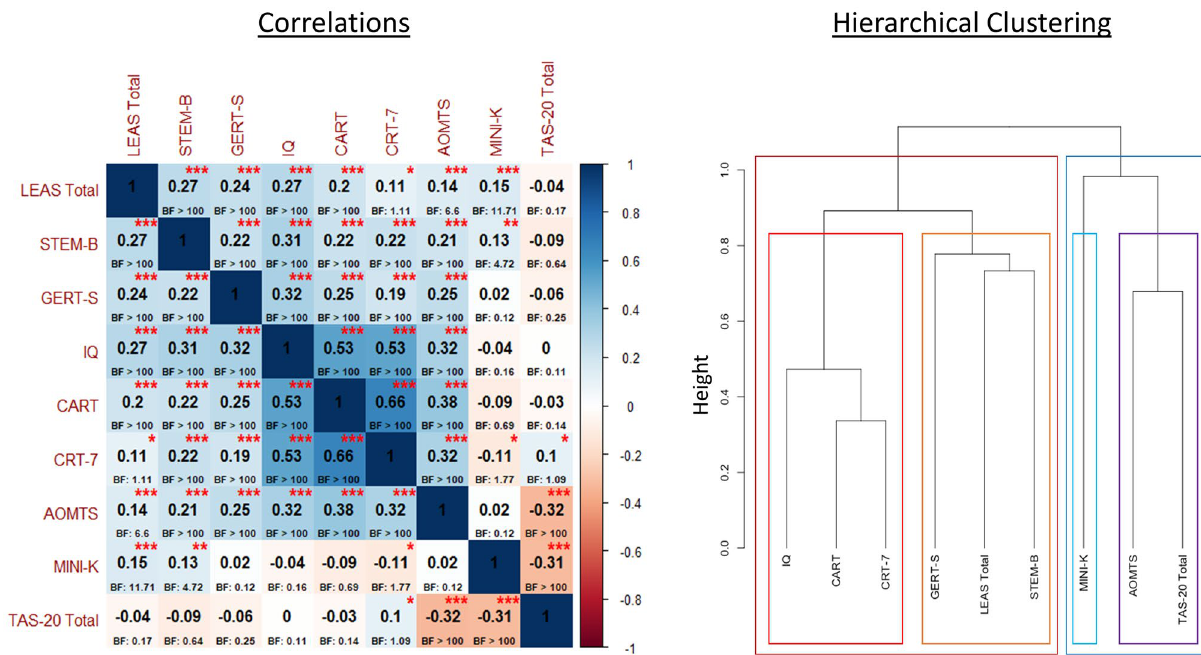
Figure 2. Left: Post hoc Pearson correlations between all variables. Although carried out post-hoc to further characterize results of prior planned analyses, for the interested reader we note their uncorrected significance levels (*p < .05, **p < .01, ***p < .001) and provide Bayes factors (BFs) from JZS Bayesian correlation analyses with default prior scales in R (see main text) indicating the level of evidence for each relationship. Right: Results of hierarchical clustering analyses. The LEAS, IQ, two performance-based general reflectiveness measures (CART, CRT-7), and two performance-based socio-emotional variables (STEM-B, GERT-S) clustered together with significant positive correlations; finer-grained clustering grouped the LEAS with STEM-B and GERT-S. The Mini-K clustered with a self-report reflectiveness measure (AOMTS) and a self-report measure of alexithymia (TAS-20) with negative correlations; finer-grained clustering separated the Mini-K from these other two variables. Note that clustering analyses were performed after making TAS-20 scores negative so that higher scores indicated higher levels of emotional